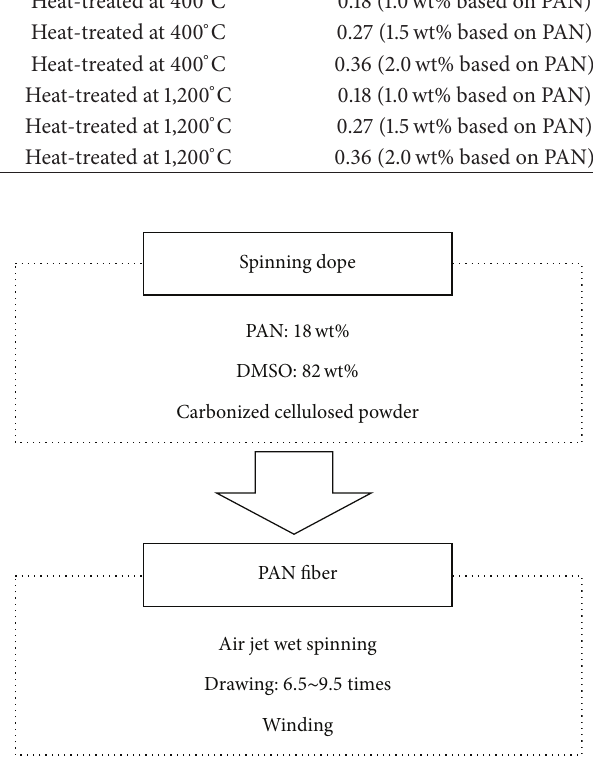
Figure 2: Preparation process of the PAN fiber containing car- bonized cellulose